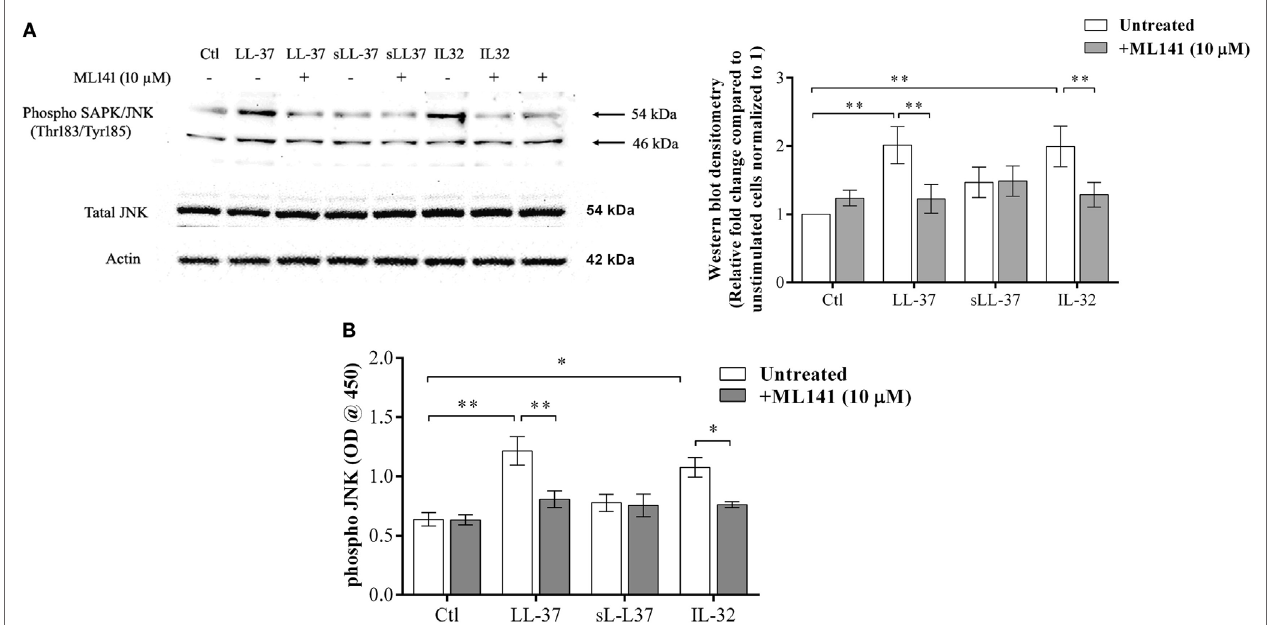
FigUre 3 | LL-37-mediated JNK mitogen-activated protein kinase (MAPK) phosphorylation is dependent on Cdc42/Rac1 RhoGTPase. Macrophage-like THP-1 cells were pre-incubated with Cdc42/Rac1 inhibitor ML141 (10 µM) for 1 h prior to stimulation with either LL-37 (5 µM), sLL-37 (5 µM), or recombinant human IL-32 γ (20 ng/ml), for 15 min. (a) Cell lysates (each containing 20 µg total protein each) were probed with phospho-JNK (T183/Y185) antibody by western blots. Antibodies against total-JNK and β -actin were used as loading controls. Densitometry analyses for western blots represent relative fold change compared to unstimulated cells normalized to 1. Results shown as mean ± SE of five independent experiments ( n = 5). (B) Cell lysates (40 µg each) were monitored by PathScan ® phospho-JNK (Thr183/Tyr185) Sandwich ELISA for relative quantitative estimation of JNK MAPK phosphorylation. Results shown as mean ± SE of four independent experiments ( n = 4). Analysis of variance with Bonferroni’s post hoc test was used for statistical analyses (* p < 0.05, ** p <